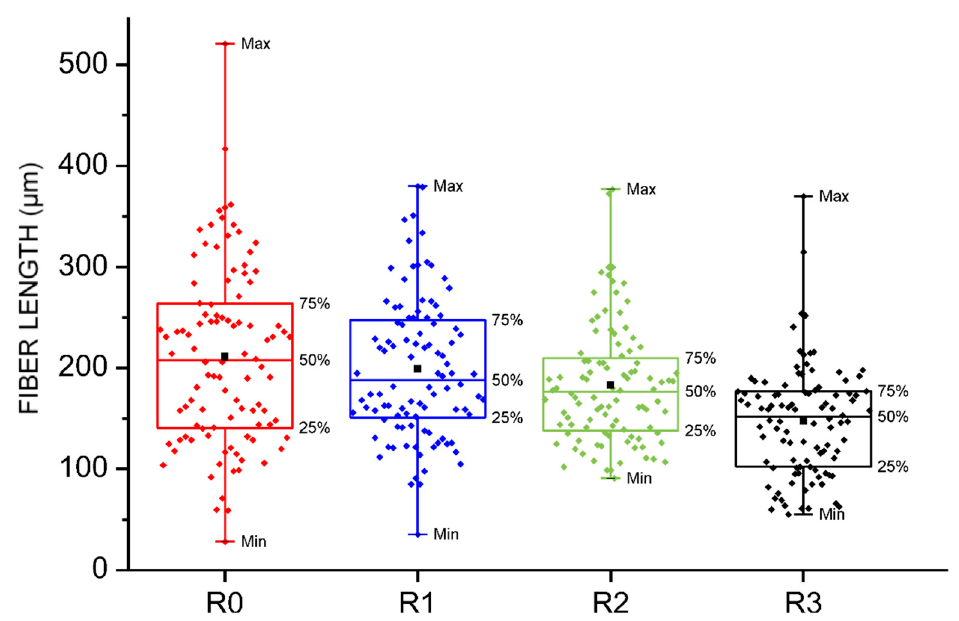
Figure 15. Short glass fiber length distribution.